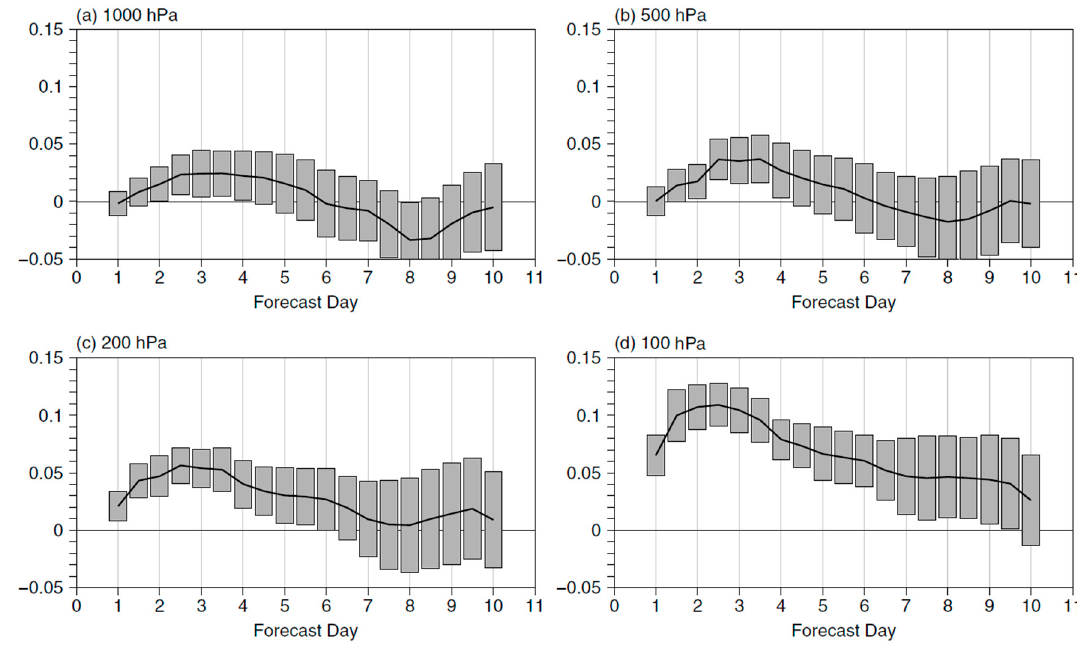
Figure 4. Impact of RO data in 100, 200, 500, and 1000 hPa on the ECMWF operational forecast in the southern hemisphere, where the positive values indicate improved NWP. The y-axis represents the fractional improvement in the RMS geopotential height errors as a function of the forecast range, which is plotted along the x-axis, in the southern hemisphere (latitude > 20°) [40]. The error bars represent the 95% confidence interval.